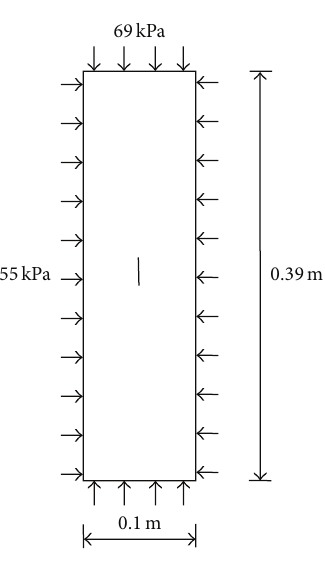
Figure 1: The simulation